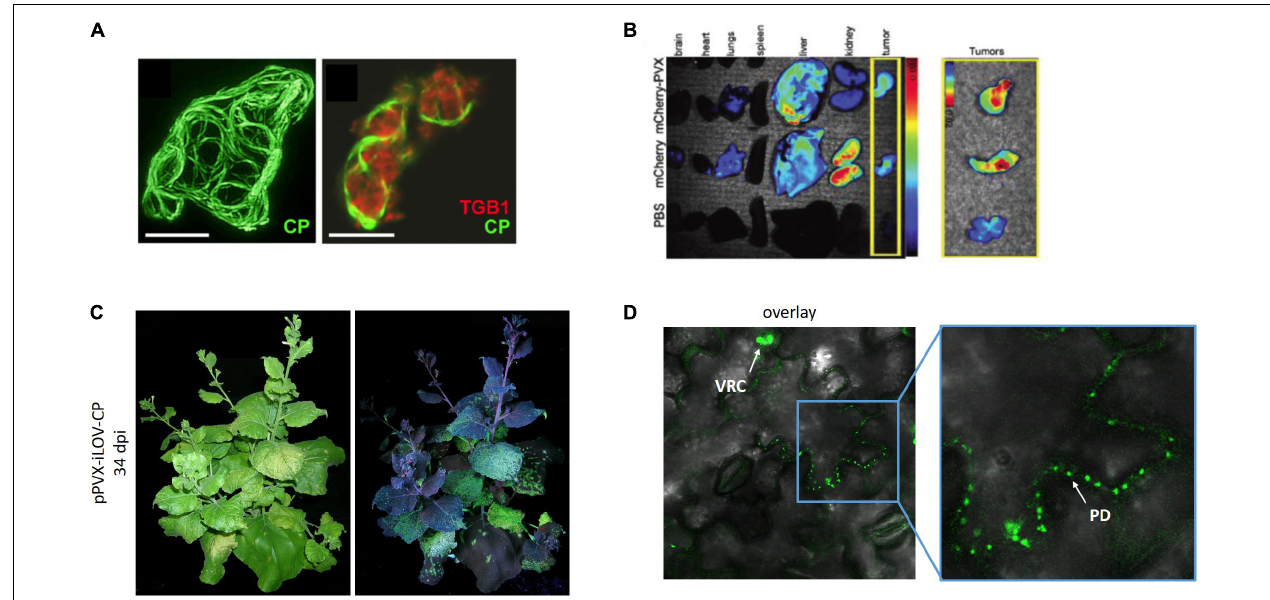
FIGURE 4 | PVX for imaging applications. (A) GFP-labeled CP and mCherry-labeled TGBp1 for subcellular localization. Reproduced with permission from Tilsner et al. (2012). Scale bar = 10 µ m. (B) Biodistribution of PVX-mCherry particles within the organs and tumors of mice (Shukla et al., 2014a). (C) Infection of N. benthamiana with PVX carrying iLOV and (D) localization of iLOV-CP direct fusion proteins within plasmodesmata (Röder et al., 2018). PD, plasmodesmata. VCR, viral replication complex. Adapted from Tilsner et al. (2012), Shukla et al. (2014a), and Röder et al. (2018).